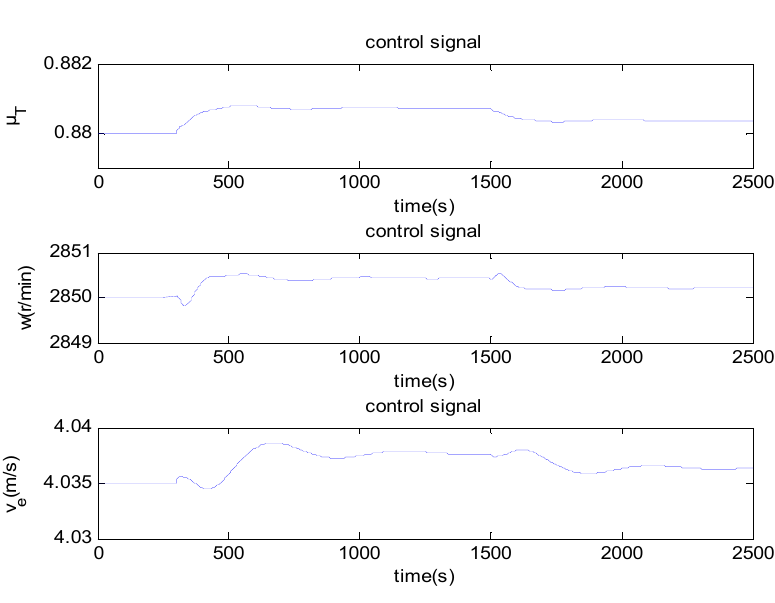
Figure 6. Responses of manipulated